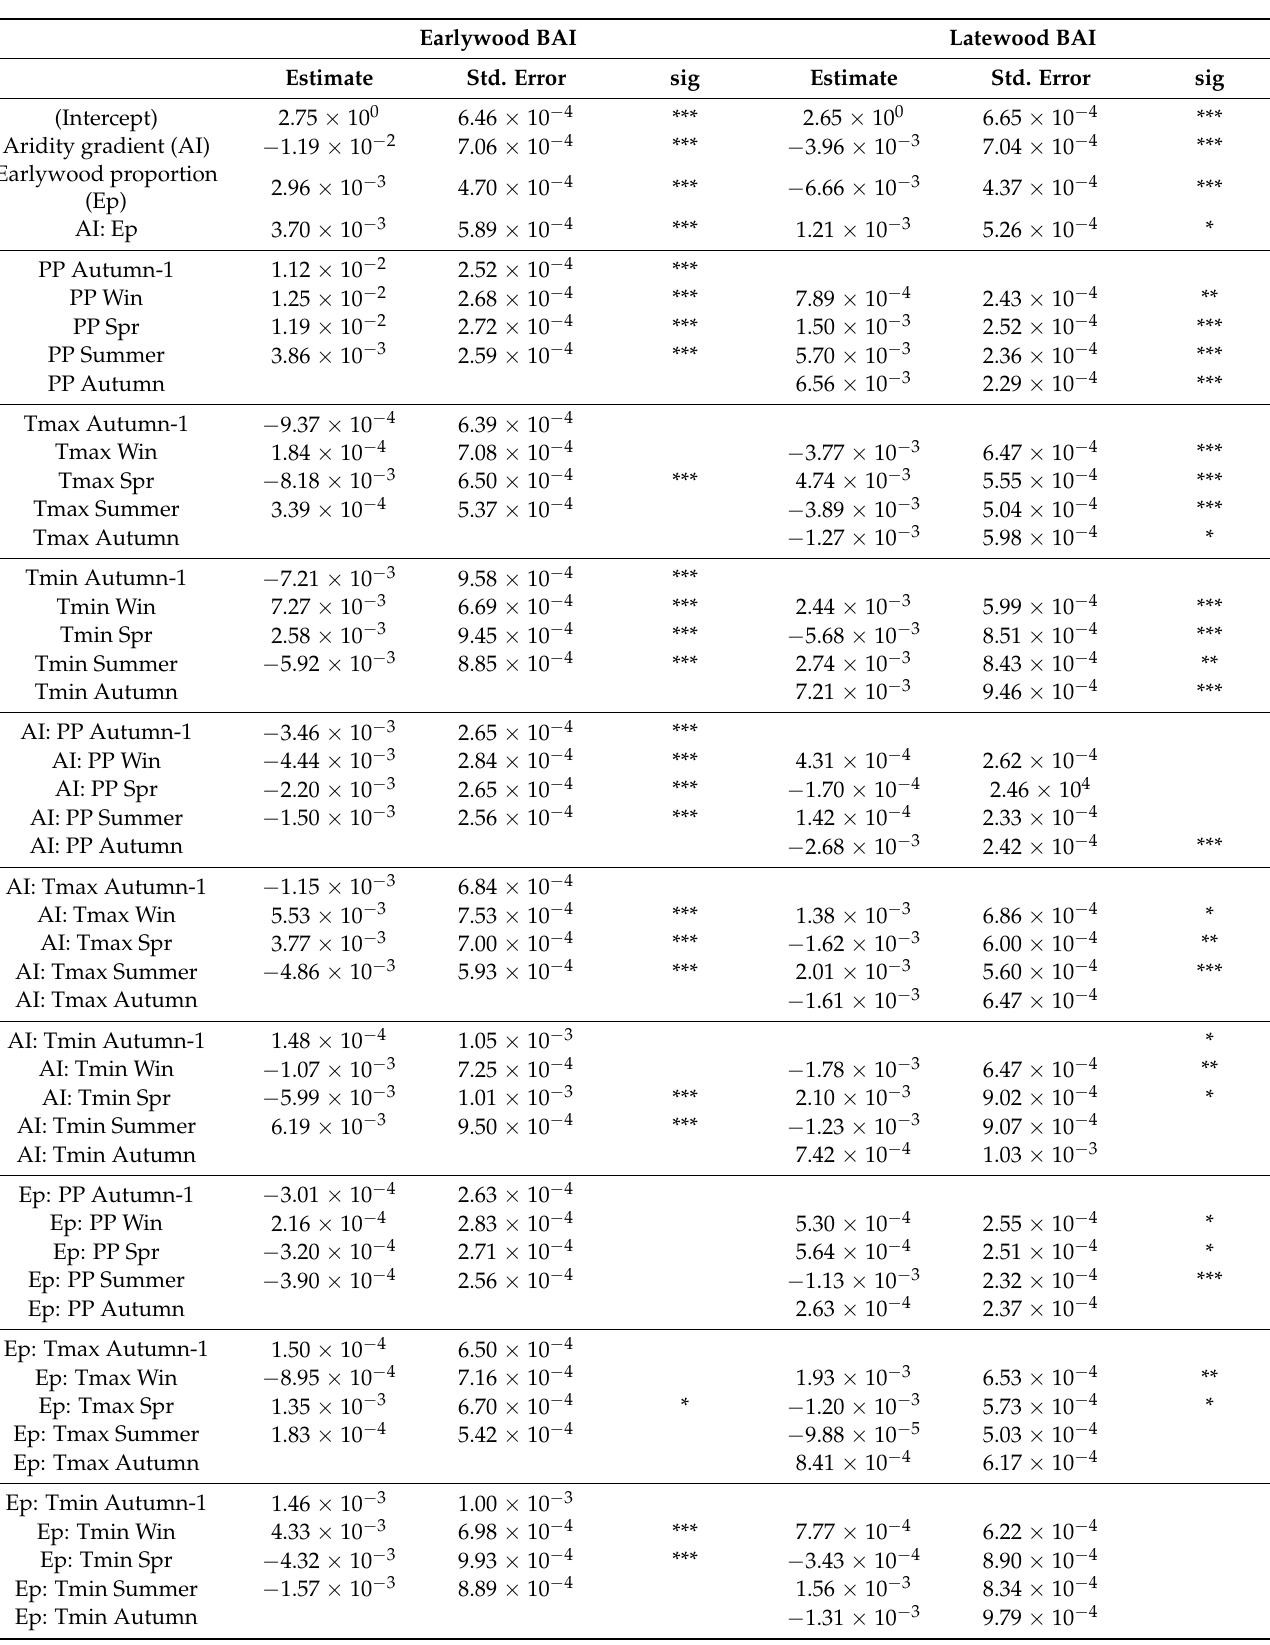
Table 1. Prediction model results for earlywood (Left) and latewood (Right). * ( p < 0.05); ** ( p < 0.01); *** ( p <